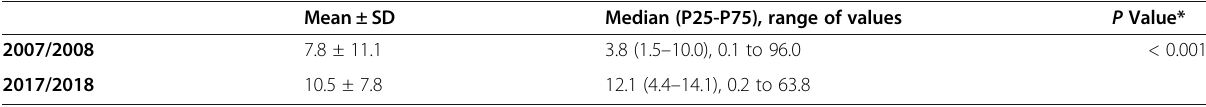
Table 4 Comparison of waiting time (months) of patients referred for first Rheumatology consultations in 2007/2008 (482 patients) and 2017/2018 (357 patients)